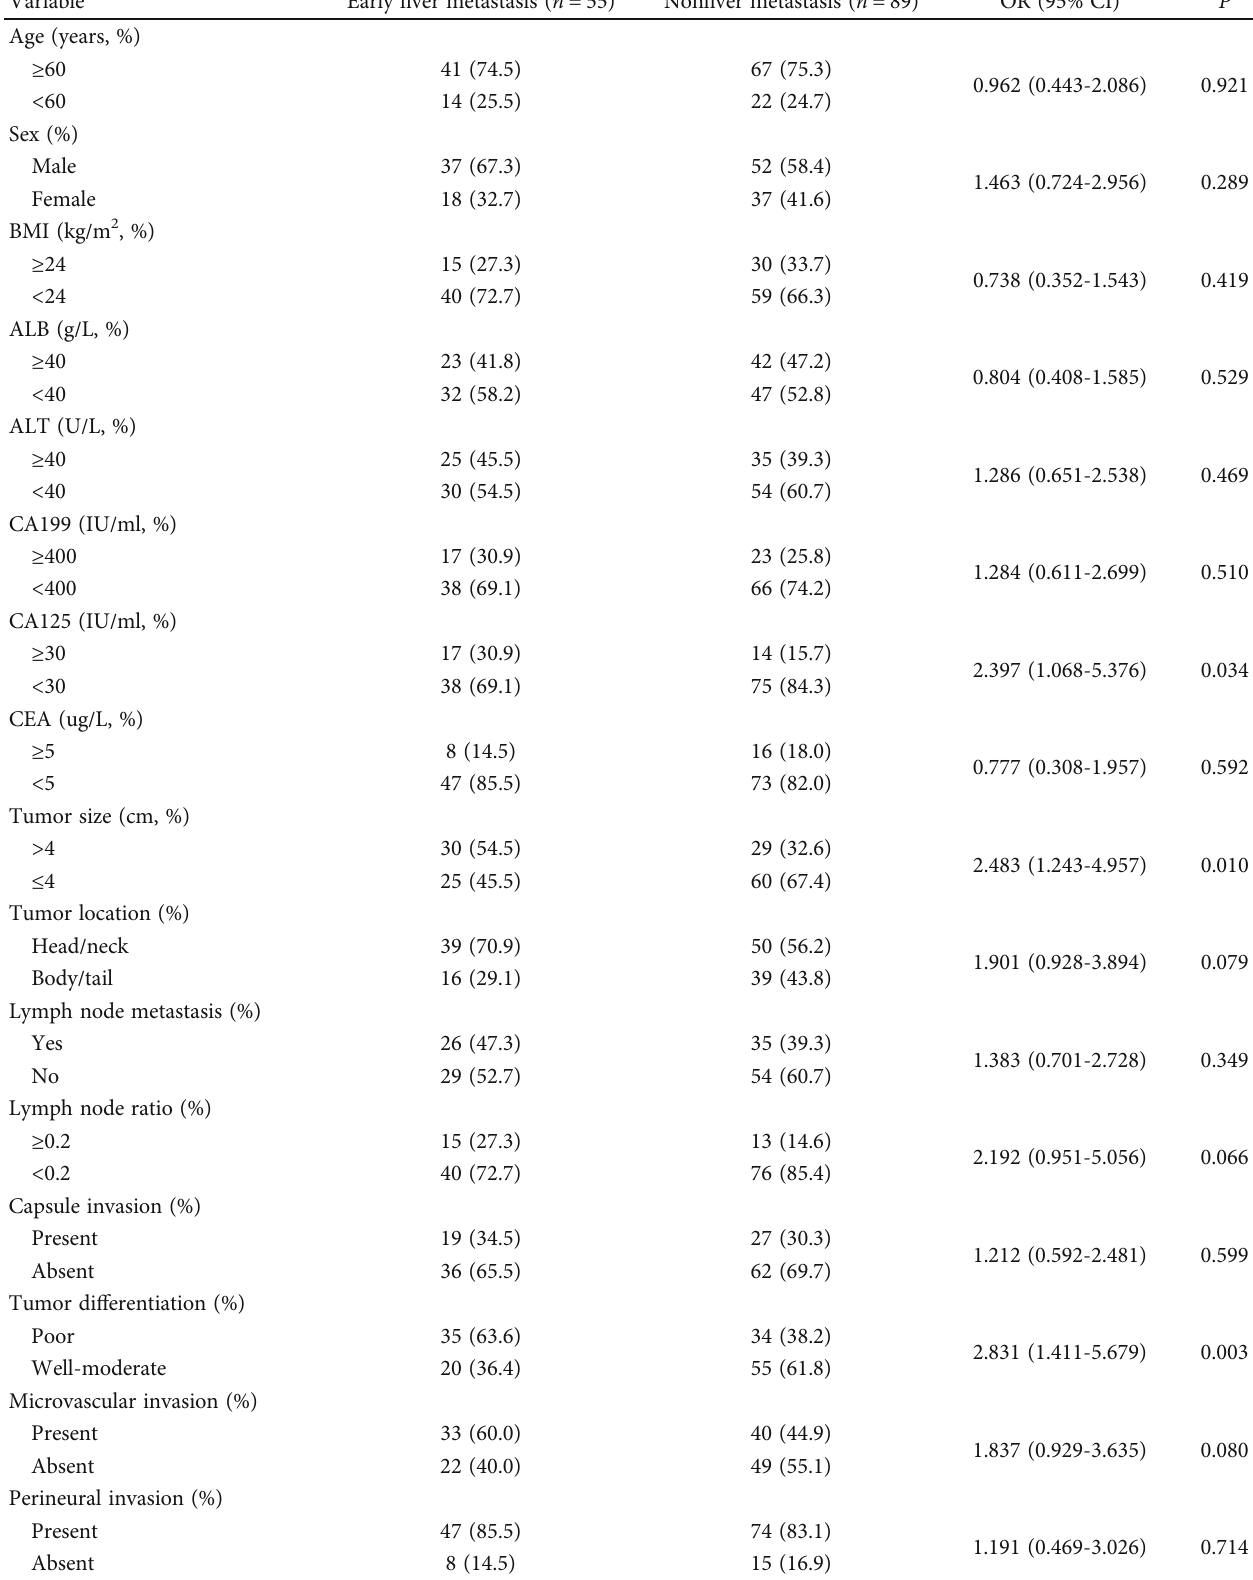
Table 3: Univariate analysis of risk factors for early liver